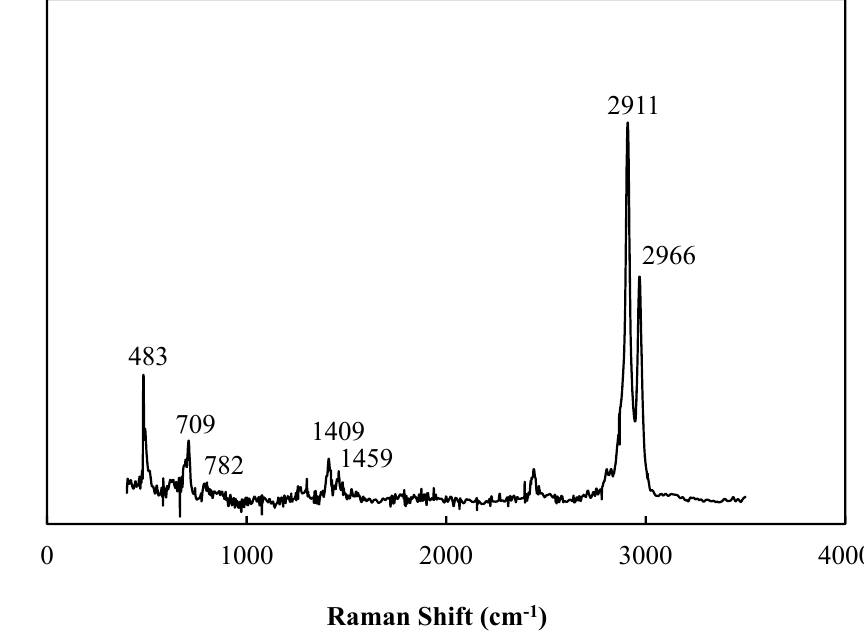
Figure 6. Raman spectrum of SiNPs.